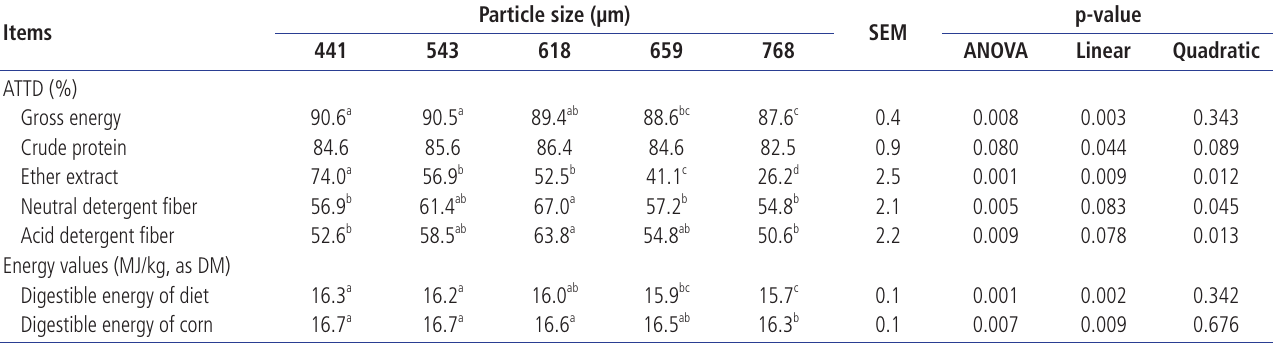
Table 4. Effects of corn particle size on the apparent total tract digestibility of nutrients and the digestible energy of corn and diet fed to growing pigs Items